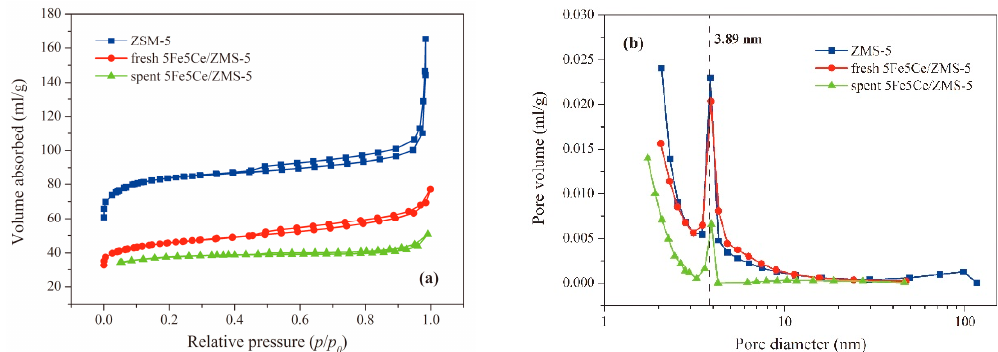
Figure 2. Textural properties of 5Fe5Ce/ZSM-5: ( a ) nitrogen adsorption-desorption isotherms and ( b ) pore size distribution. Table 1. Brunauer-Emmett-Teller (BET) specific surface area ( S BET ), total pore volume ( V total ), spent 5Fe5Ce/ZSM-5.